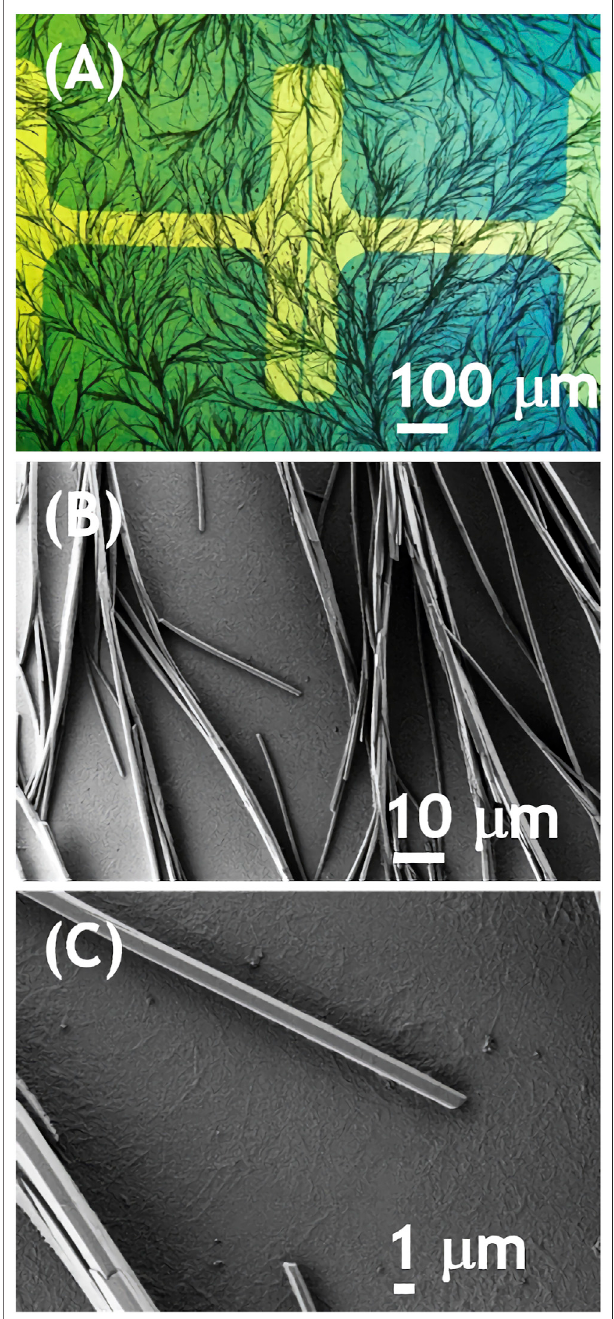
FIGURE 3 | Optical (A) and scanning electron (B, C) micrographs of P3HT:NDIC8 blend spray-coated and solvent annealed on an OFET